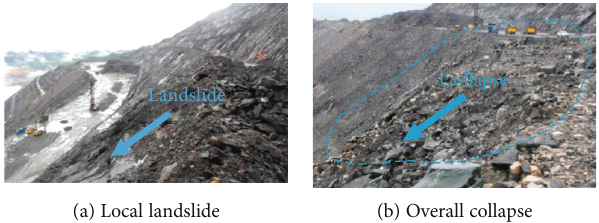
Figure 2: Landslides and collapses caused by rainfall [7].